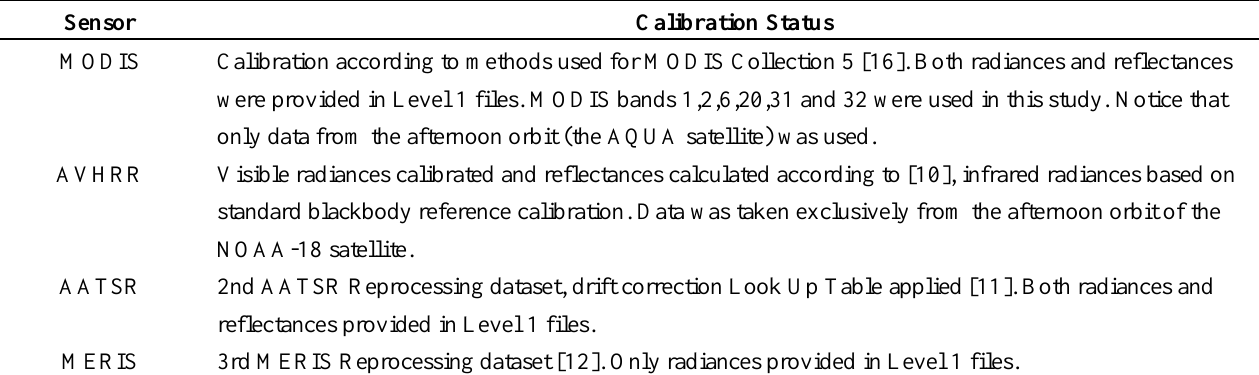
Table 1. Status of calibration for involved sensors. Applicable references are indicated where further details of the applied calibration methods are